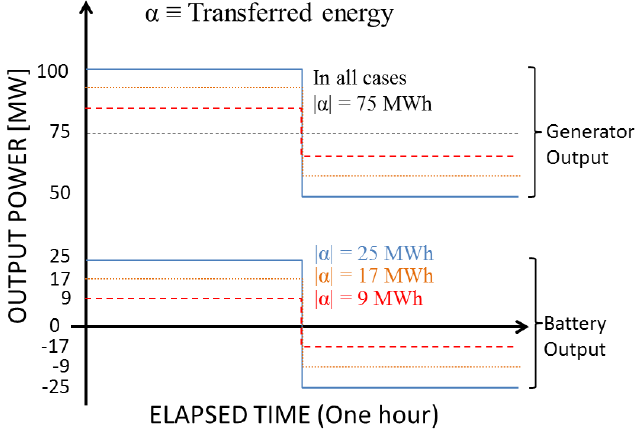
Figure 1. Conceptual diagram to show different amounts of transferred